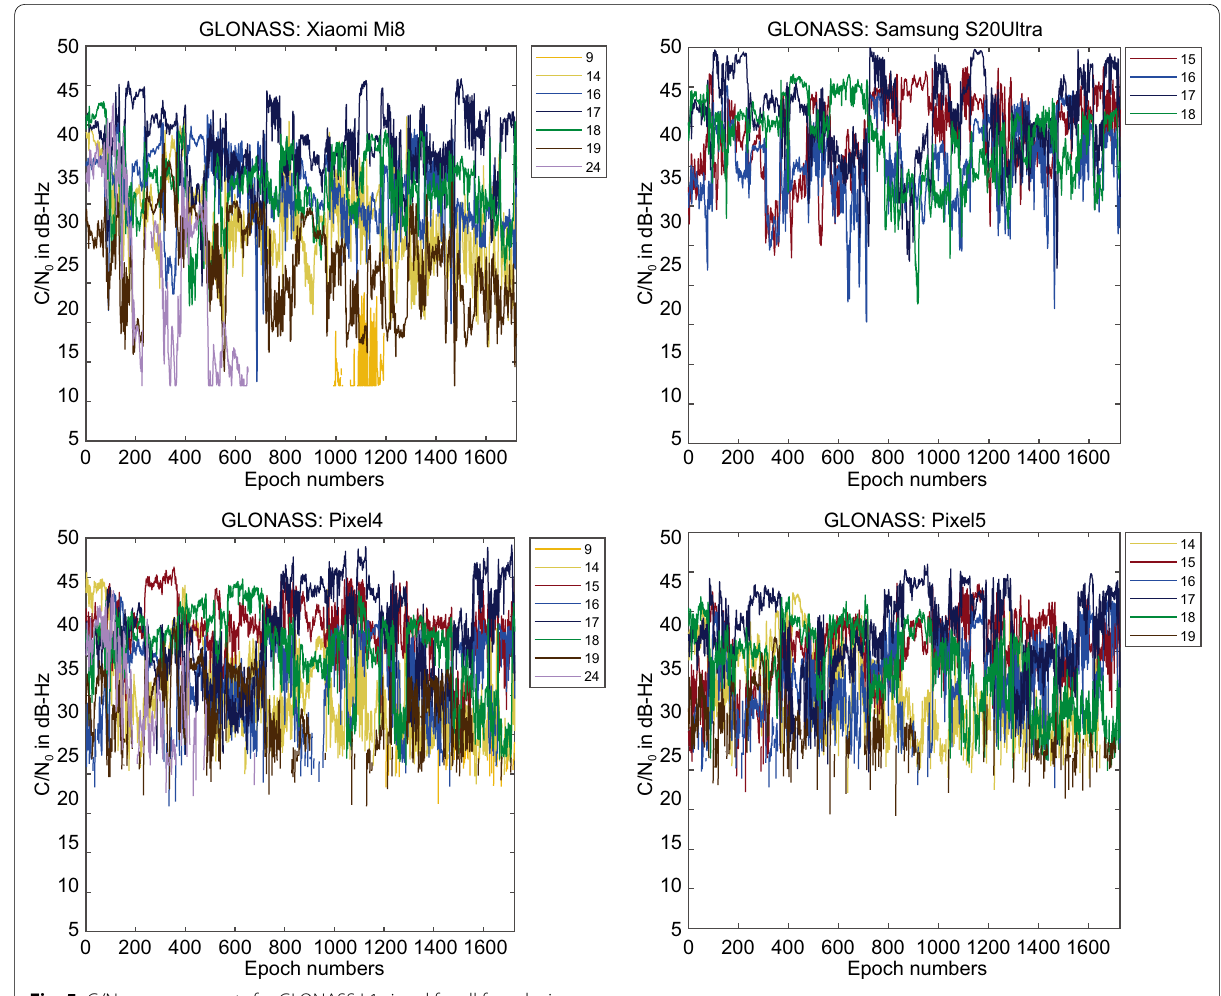
Fig. 5 C/N 0 measurements for GLONASS L1 signal for all four devices